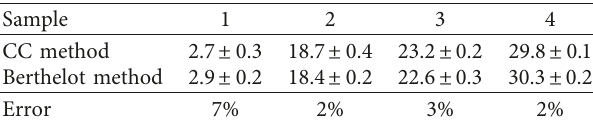
Table 1: Detection concentrations (mg L − 1 ) for the 4 samples by the two methods.